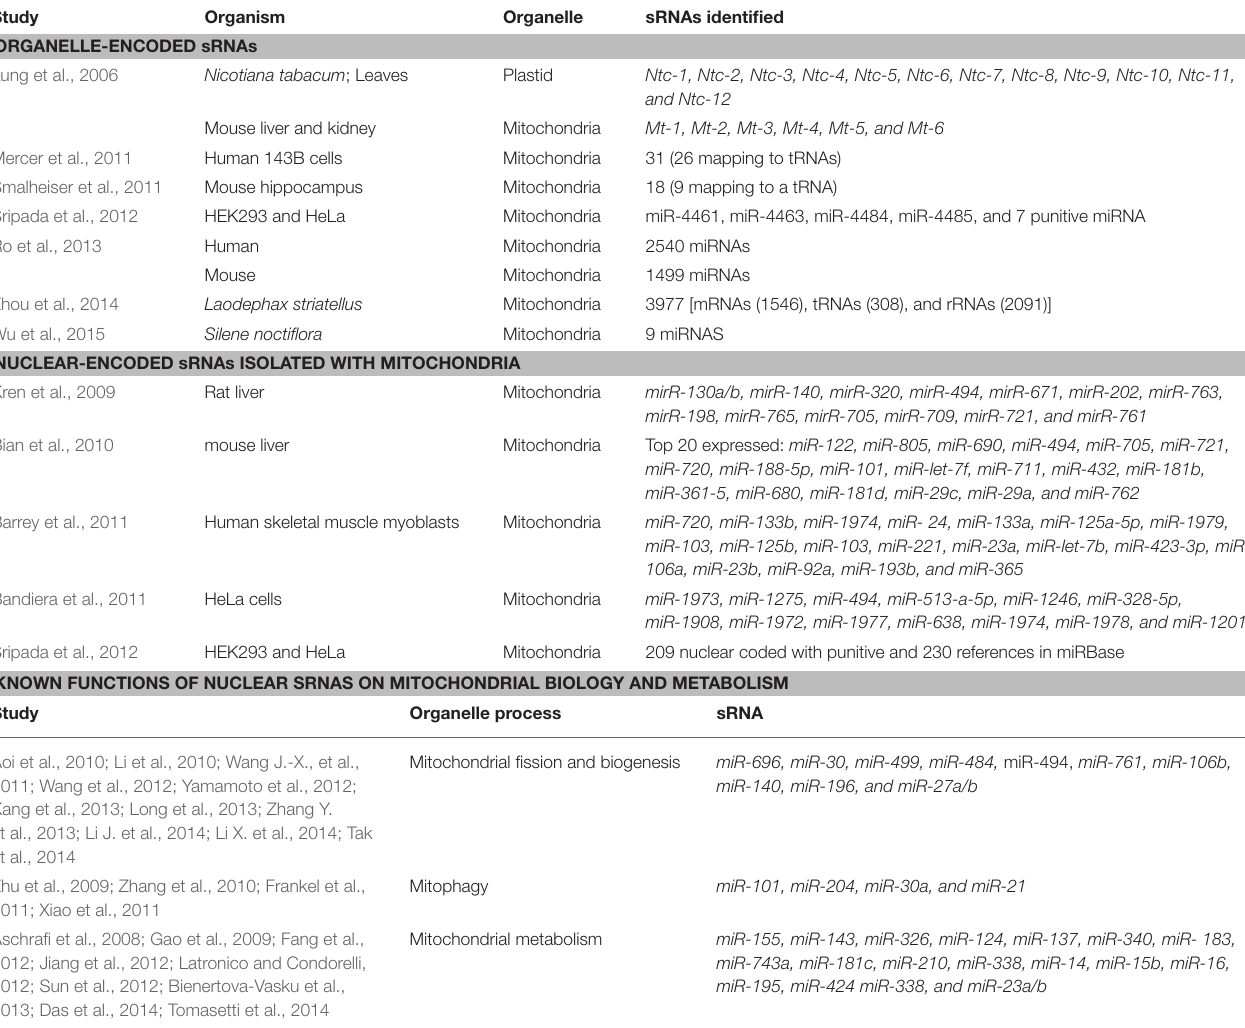
TABLE 3 | Summary of studies isolating mitochondrial/plastid-encoded sRNAs and nuclear-encoded sRNAs found within organelles.